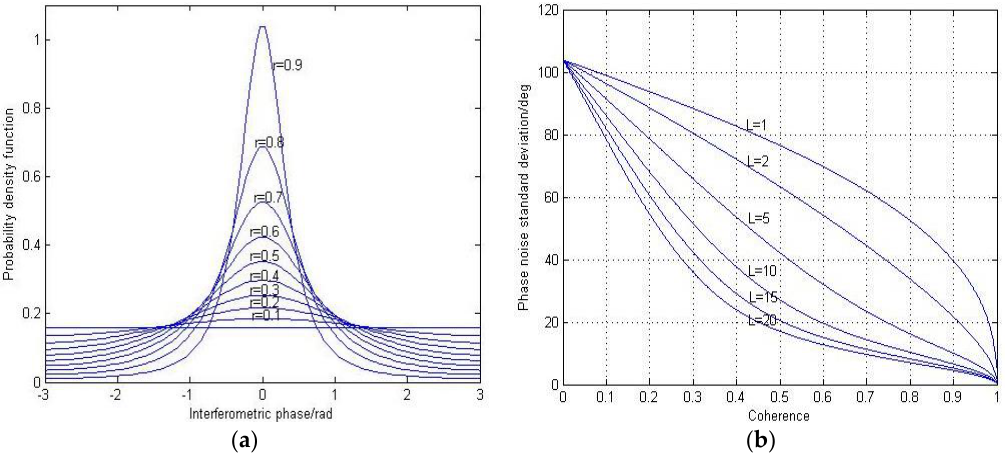
 ; ( b ) Phase standard deviation x